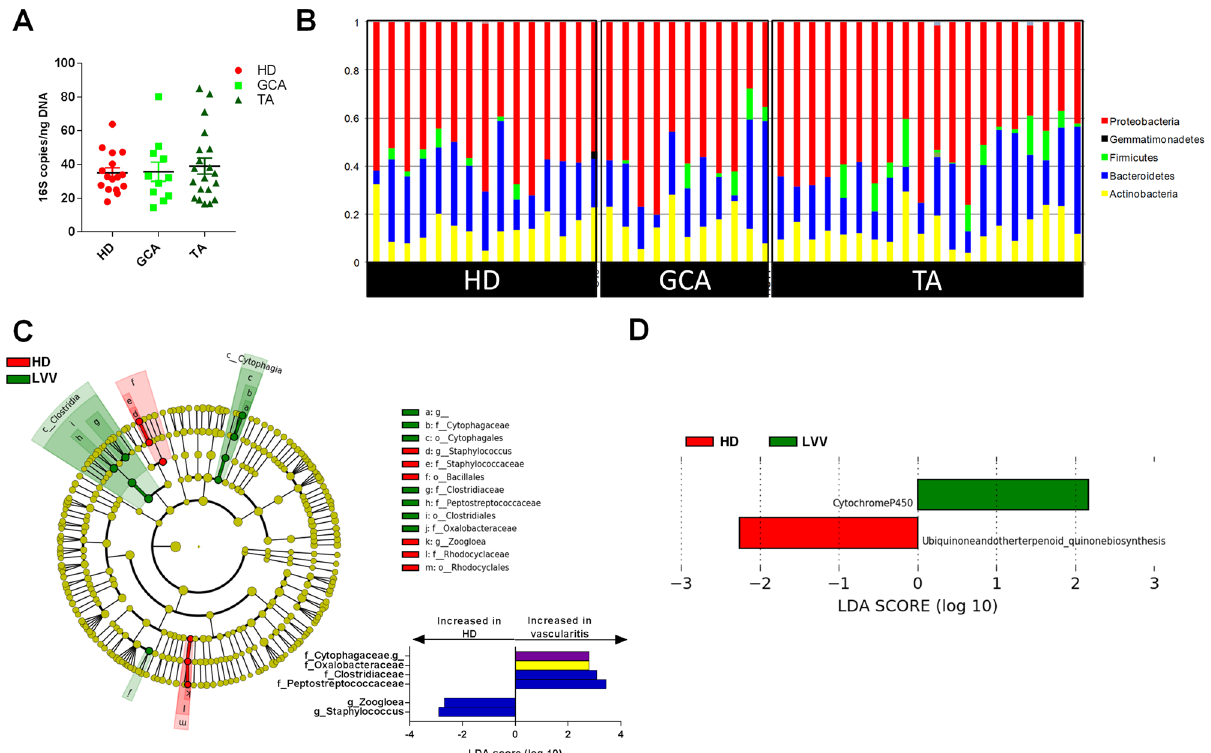
Figure 1. Circulating microbiome profile in patients with large vessel vasculitis (LVV). ( A ) Absolute quantity of bacterial 16 s DNA measured in the samples in the different groups. ( B ) Histograms of the circulating microbiome composition at the phyla level in HD (n = 15), GCA (n = 11) and TAK (n = 20) patients. ( C ) LDA effect size (LEfSe) cladograms showing the taxa most differentially associated with LVV (n = 26, green) or HD (n = 15, red) (Wilcoxon rank-sum test, p < 0.05). Circle sizes in the cladogram plot are proportional to bacterial abundance. The circles represent, going from the inner to outer circle: phyla, genus, class, order, and family. ( D ) KEGG pathway contributions of predicted metagenomic data in LVV and HD patients (Wilcoxon rank- sum test, p < 0.05) (GCA, giant cell arteritis; TA, Takayasu’s arteritis; HD, healthy blood donors). (i) Alpha diversity—degree of taxa diversity (OTU) within a sample without regard to specific organisms present. (ii) Beta diversity—degree of microbial similarity (or dissimilarity) between 2 samples taking into account specific taxa